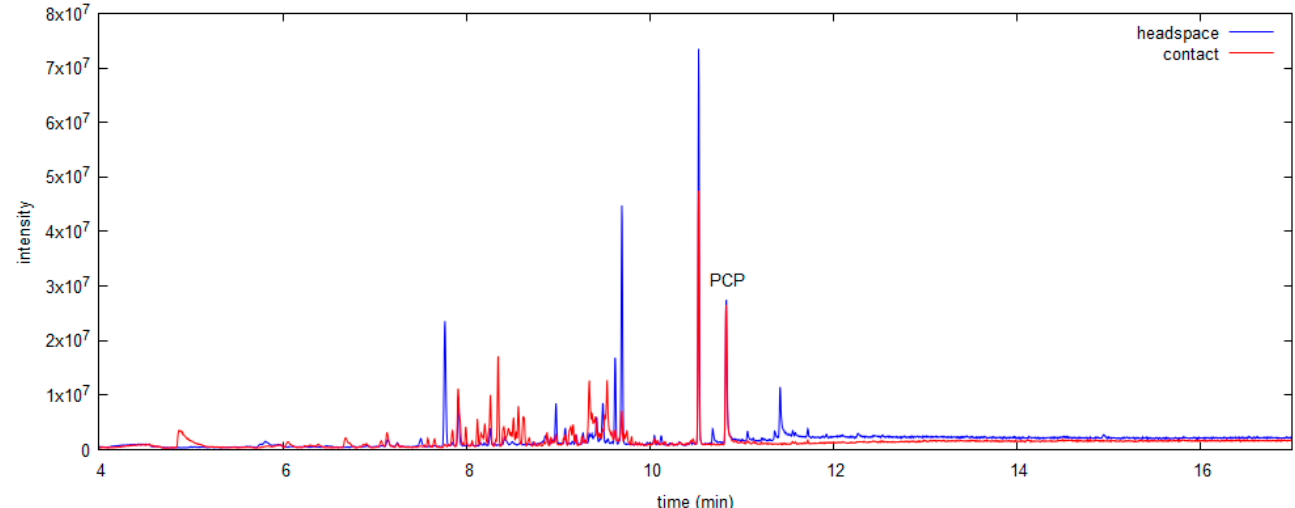
Figure 5. Comparison of GC–MS chromatograms (TIC) of a model wood sample in HS and contact SPME mode.